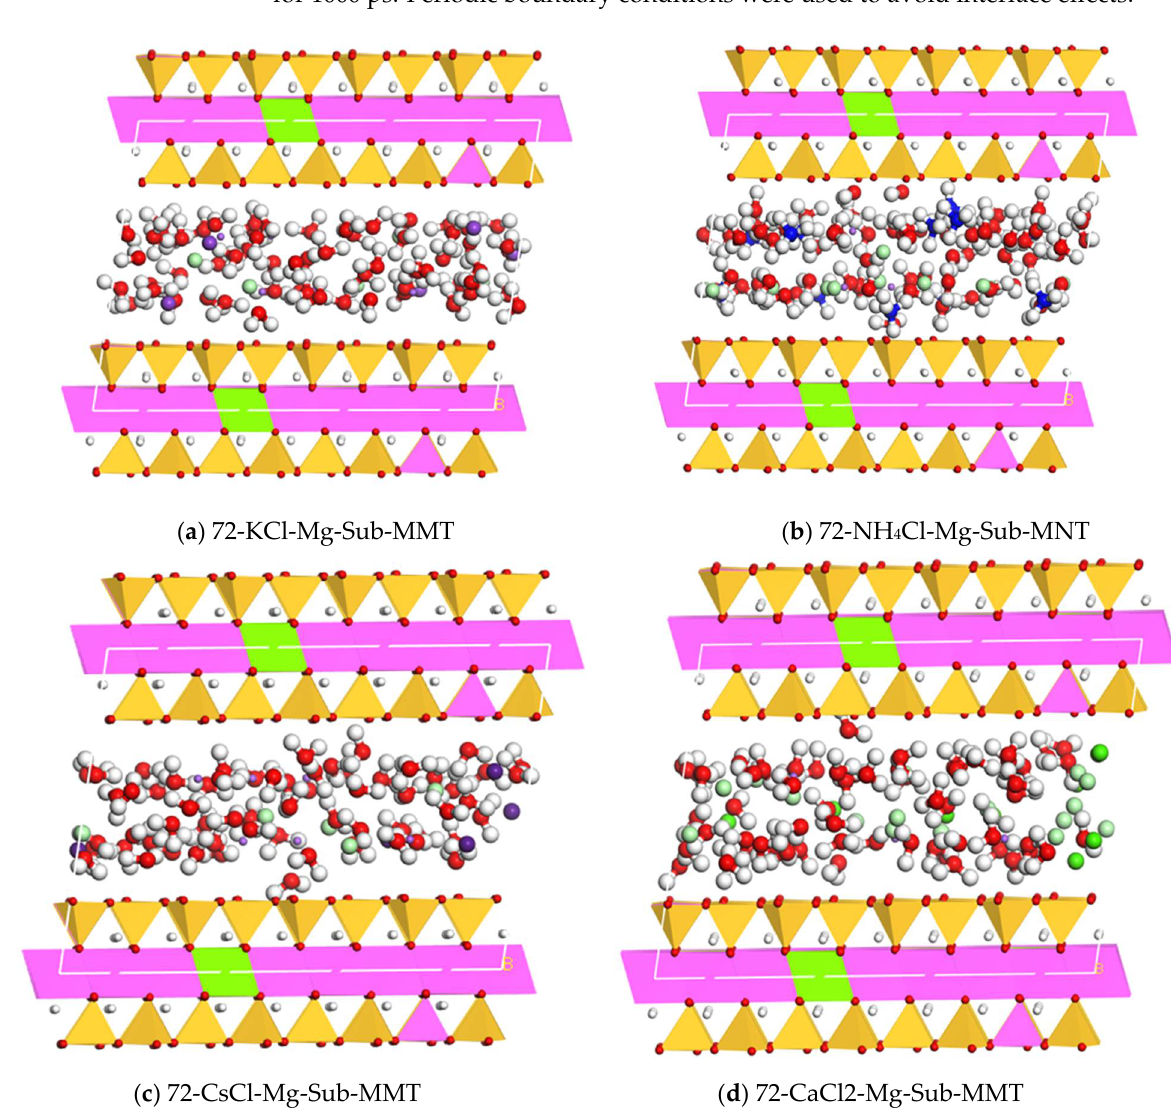
Figure 2. Initial structure of Mg-Sub-MMT with saturated salt solution. The color coding for the atoms is H, white; O, red; Mg, green; Al, pink; Si, gold; K, violet; N, blue; Cs, deep purple; Ca, yellow-green; Cl, lavender.